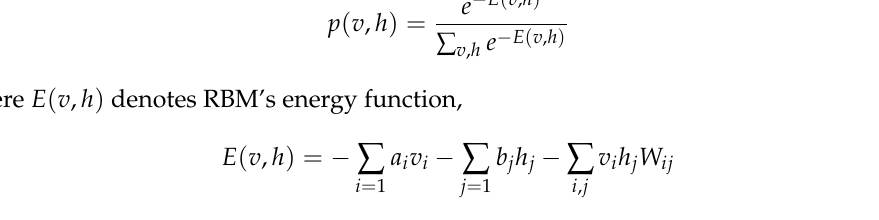
Figure 5. Stacked up RBMs model DBN.